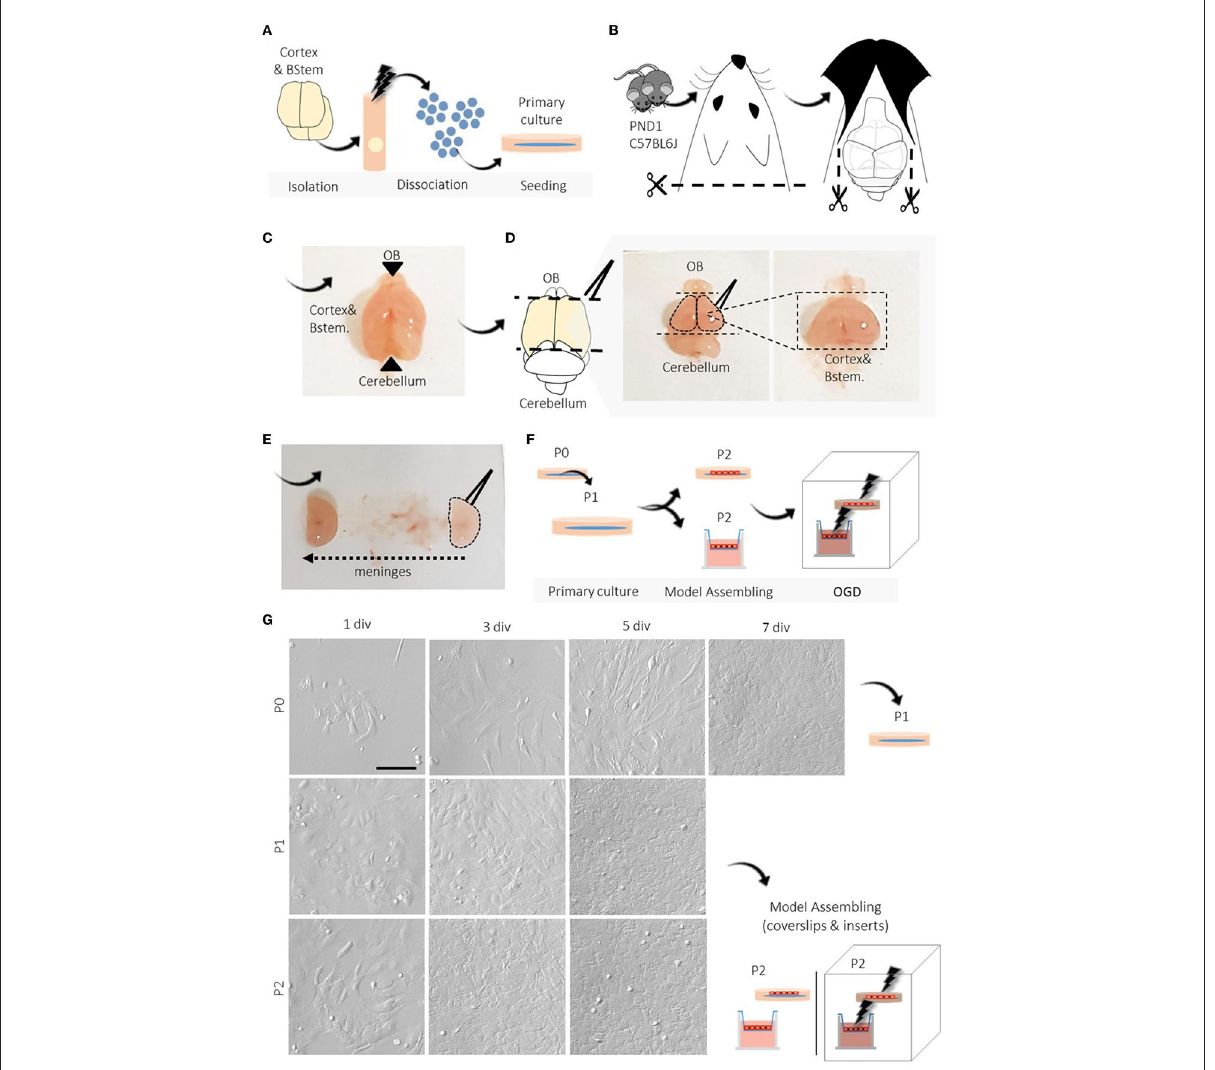
FIGURE1 Overview of BMECs protocol from newborn mice and primary culture. (A–F) Schematic representation of the primary step-by-step procedures. (G) Representative light microscopy images of the progression and evaluation of the cell culture after isolation, P0, P1, and P2. During each passage (P0, P1, P2), we photographed the cell cultures at different periods until reaching confluence (1, 3, 5, and 7 div). N = 3. PND1, postnatal day 1; OGD, oxygen-glucose deprivation; div, days in vitro; P, passage; SD, standard deviation. Scale bar 100 µ